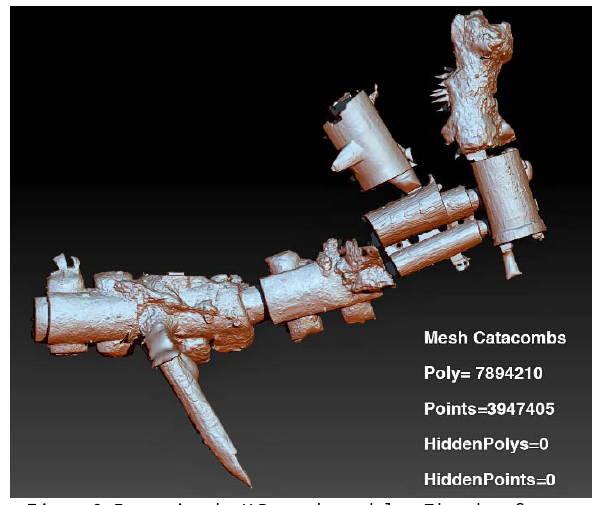
Figure 6. Importing the HD mesh model on Zbrush software, preparing for polygonal